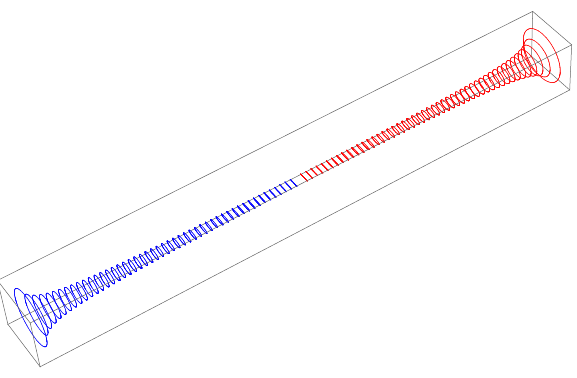
Figure 6 . The funnel solution: the two ends at s = (cid:6) s 0 are the locations of the two M5-branes. Each ring is a constant s hypersurface and represents a squashed S 3 whose radius blows up at the ends and which collapses to a three-ball at the